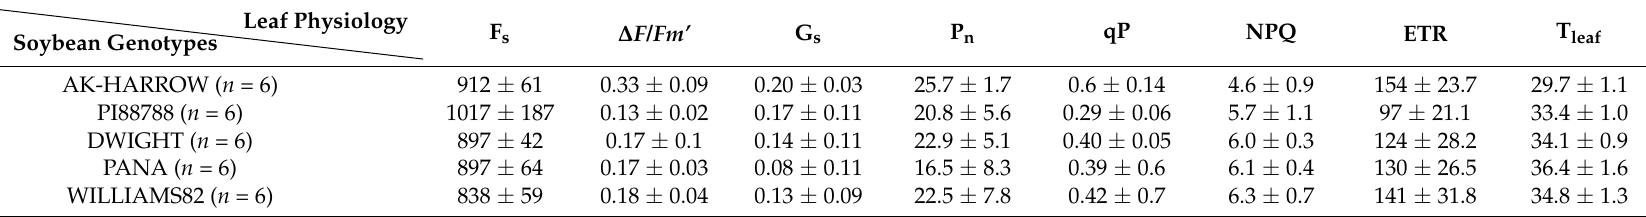
Table 1. Leaf gas exchange and Chl a fluorescence measured for the different genotypes, under conditions of light intensity = 1000 µ mol m − 2 s − 1 , CO 2 = 400 µ